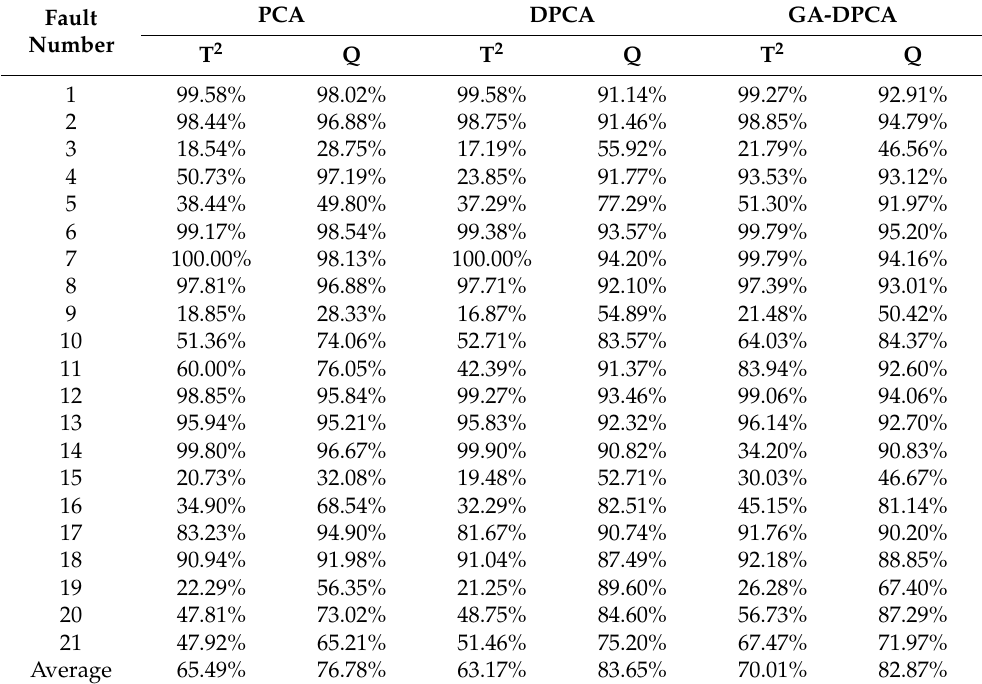
Table 3. Fault diagnosis rate of four methods for the TE